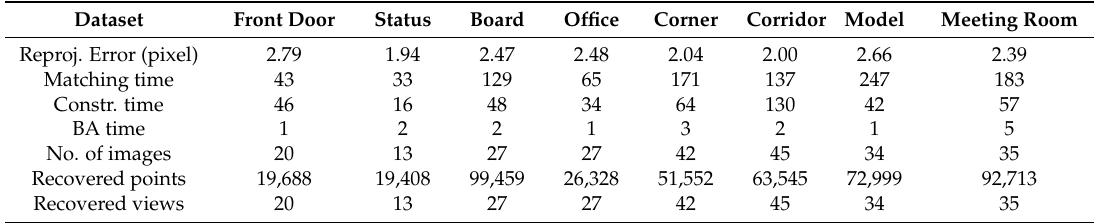
Table 5. The reconstruction information for the atomic models of the lobby dataset (time units: s).